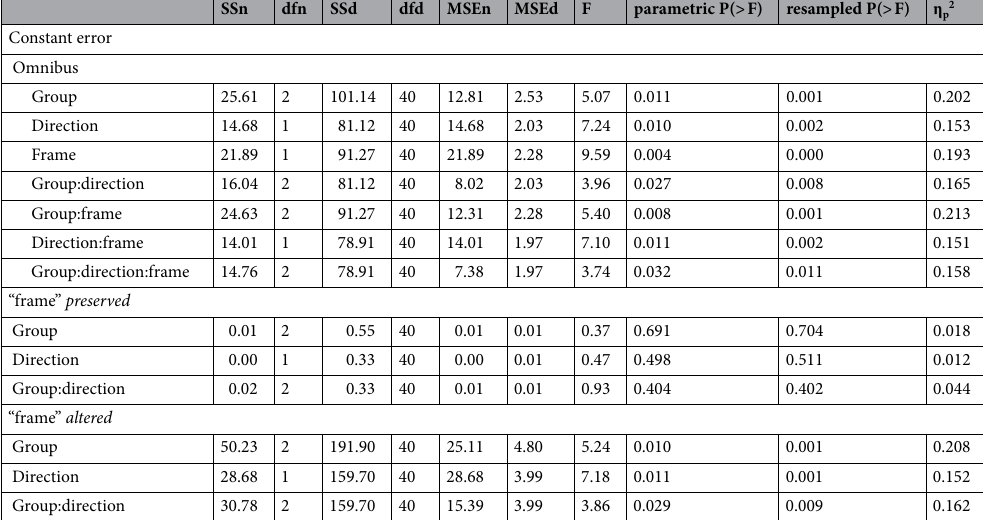
Table 1. Results of the permutation-based mixed ANOVAs performed on the constant error distributions. Parametric p-values are those computed using the classic analytical estimation, while resampled p-values are those computed via permutations. Since the data do not respect the assumptions for parametric ANOVAs, this study considered the permutation-based p-values.